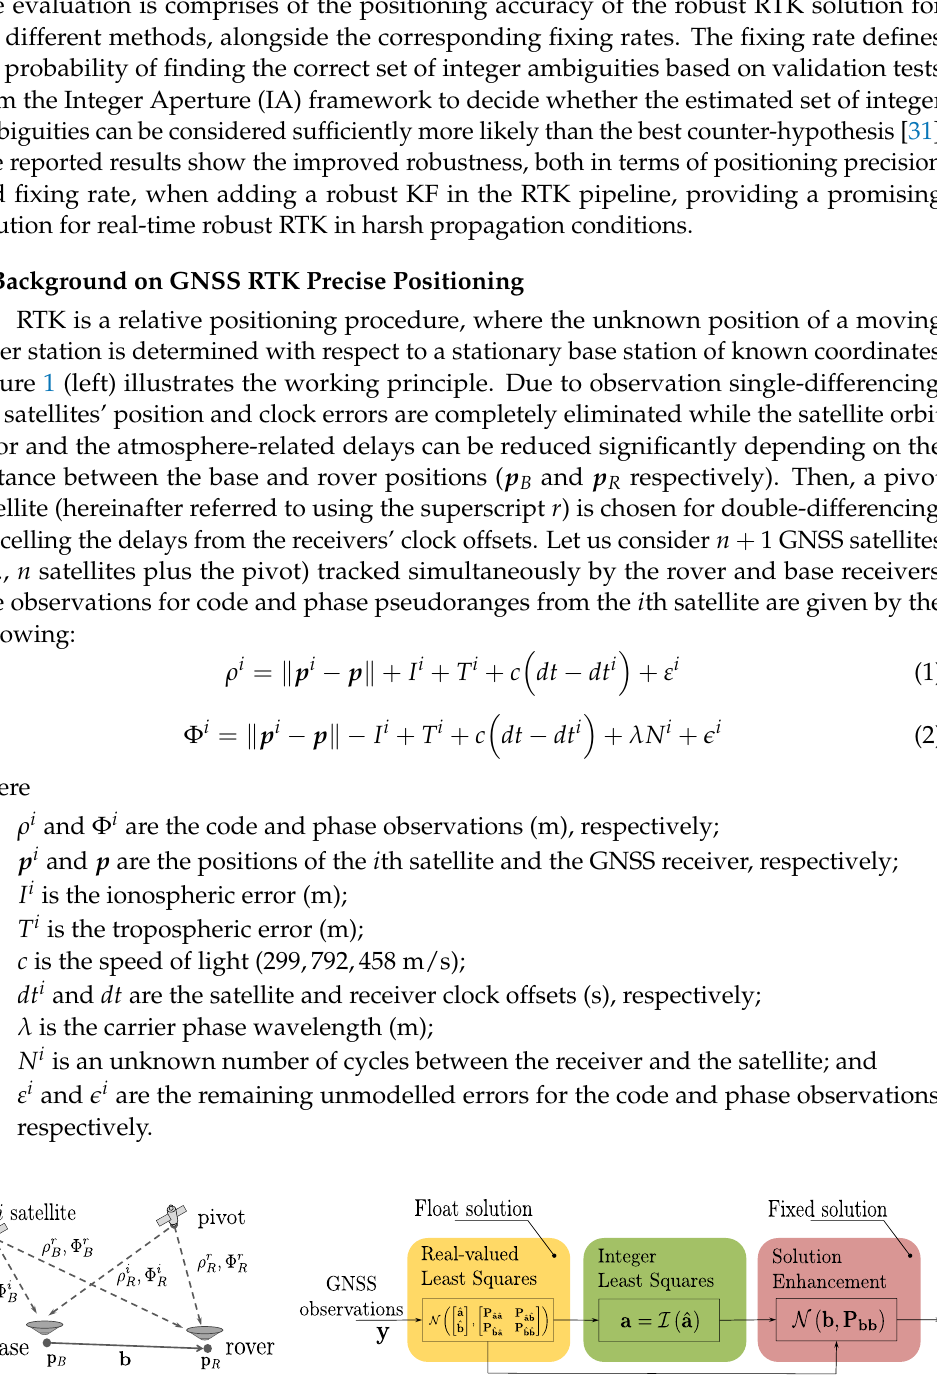
Figure 1. On the ( left ), a scheme for the real-time kinematic (RTK) procedure. On the ( right ), the workflow for the ambiguity resolution